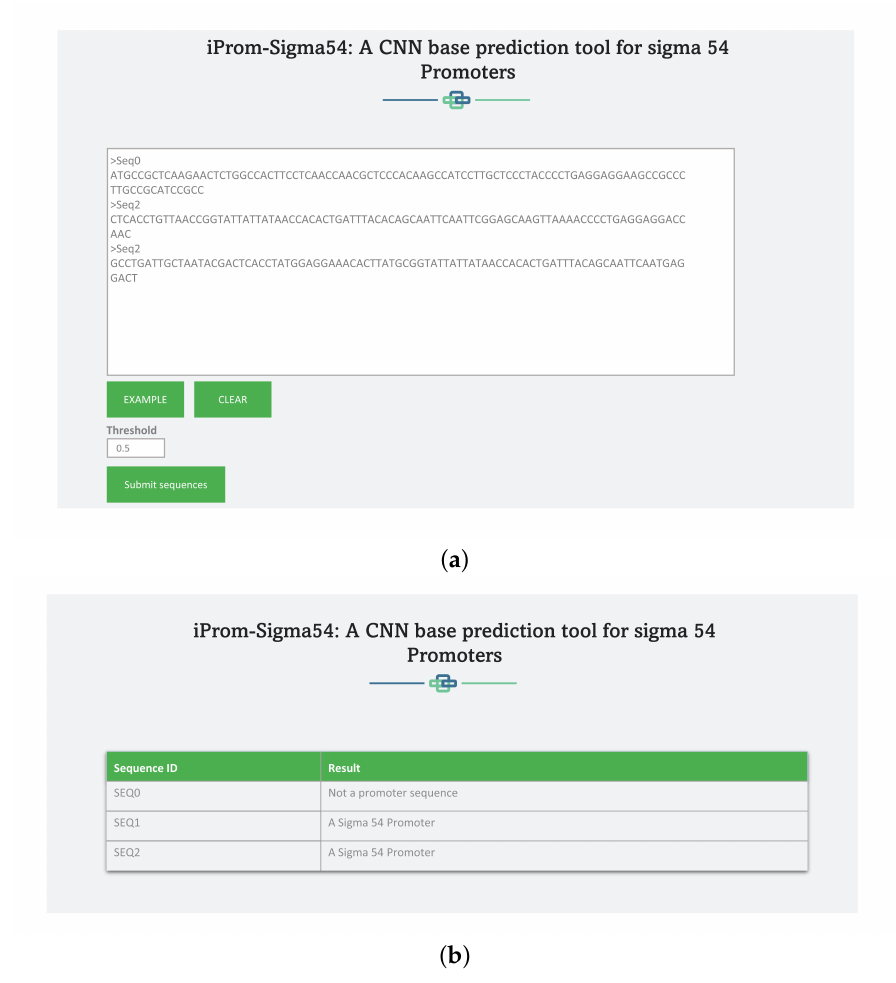
Figure 6. Webserver of iProm-Sigma54: ( a ) Adding Sequences for Prediction to Web server. The Query Sequence should be in Fasta format and must contain only A , C , G , T . ( b ): Predictor Output for Query Sequences. Table shows output for each query